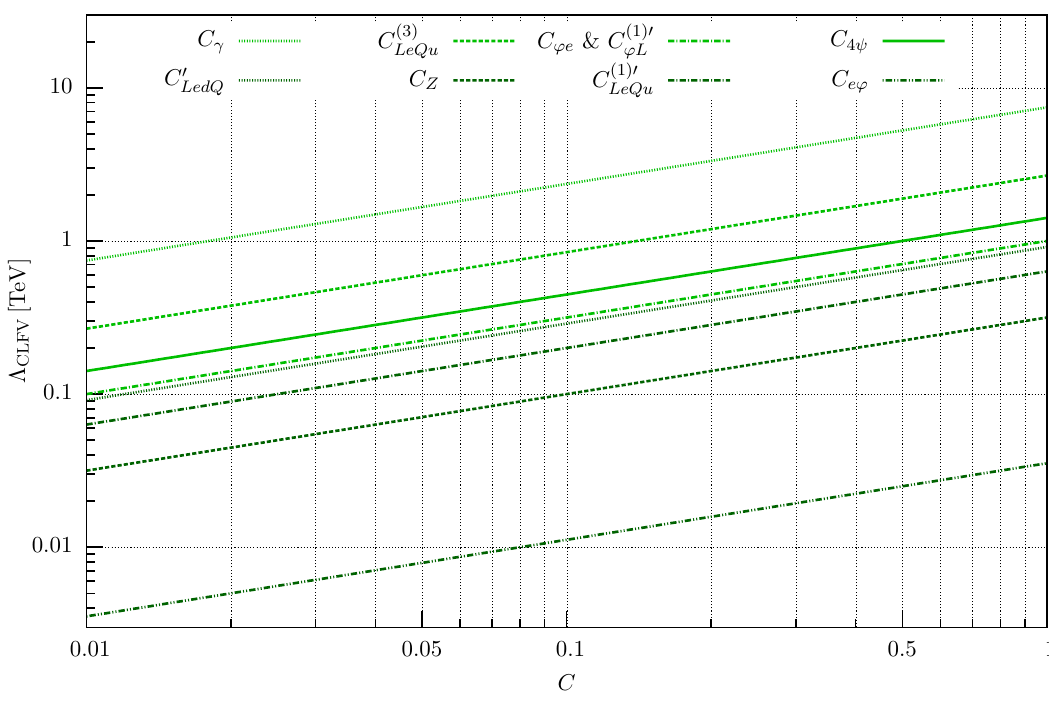
Figure 7 . Constraints on Λ CLFV with respect to the values of WCs from µ - τ conversion in Fe(56,26), based on the expected sensitivity of the NA64 experiment, given at the 99.8 % confidence level.